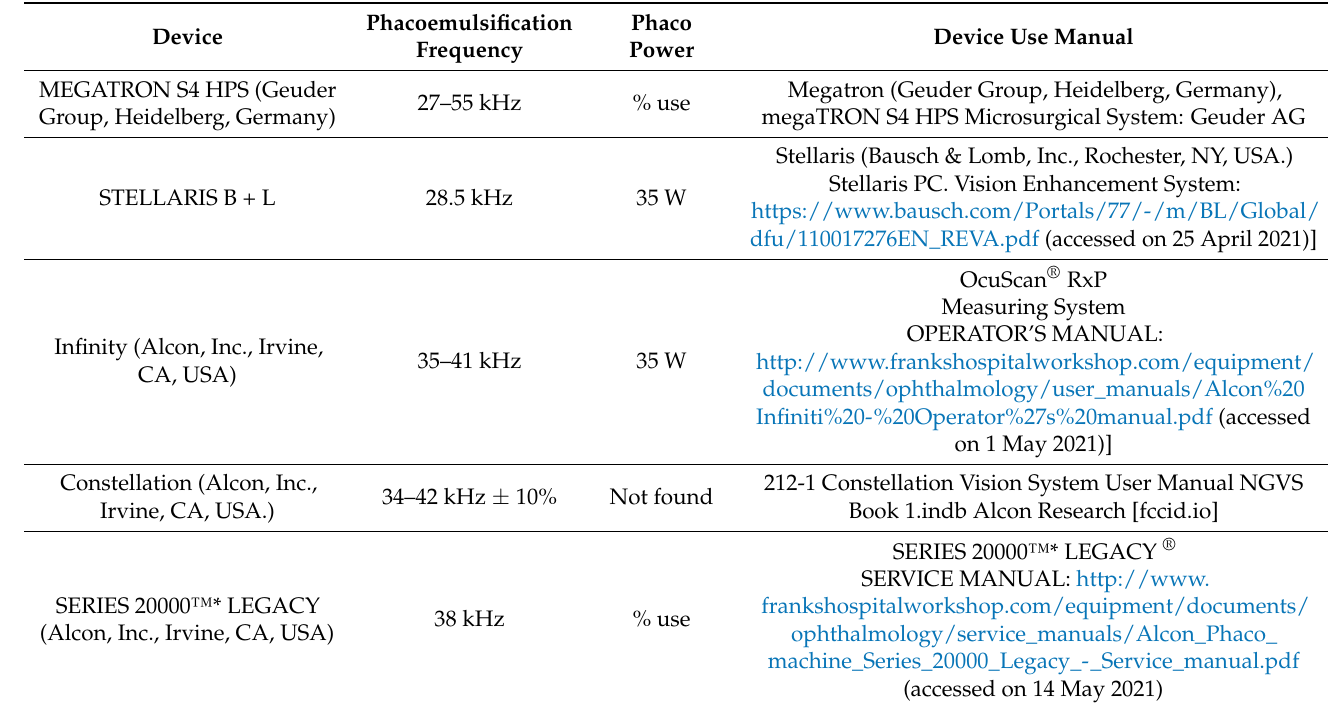
Table 1. The frequency and power of U/S devices and links to the user manuals for the devices.